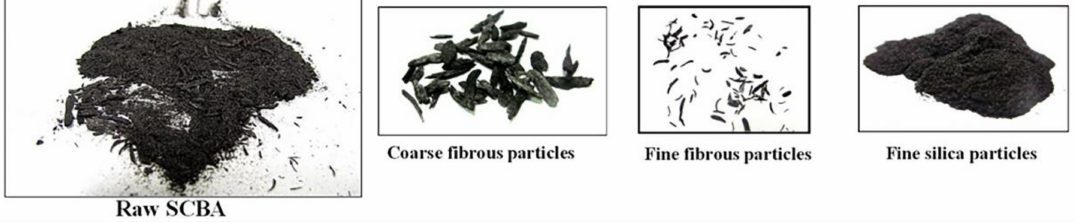
Figure 3. Morphology of raw SCBA from power plants. Reproduced with permission from [32].